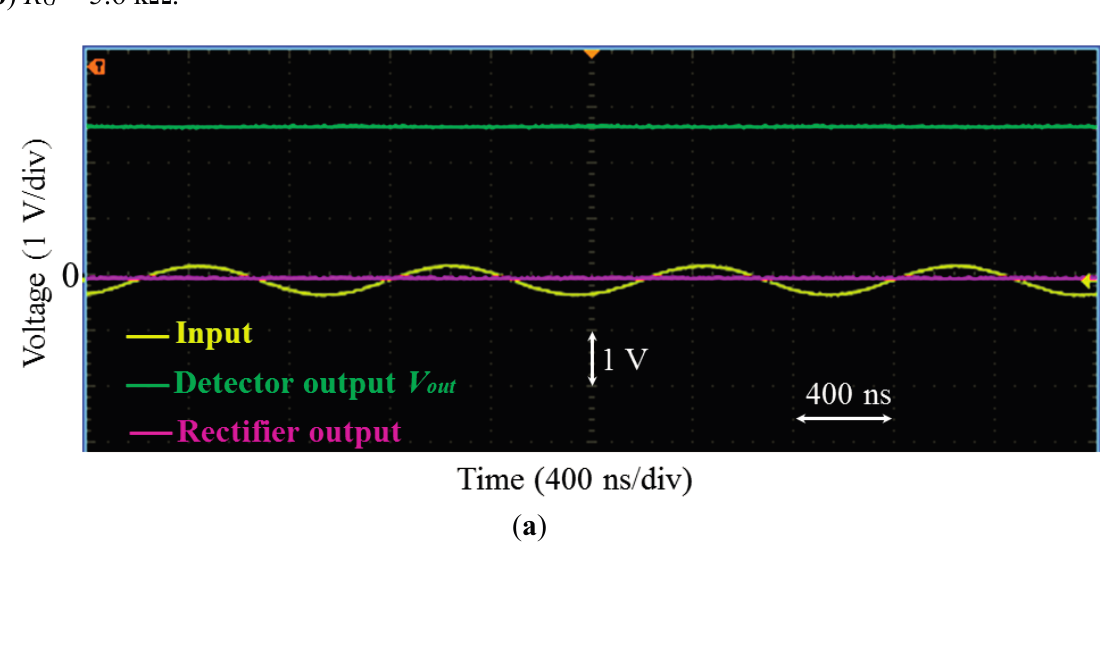
Figure 8. Input signal (yellow color), detector output (green color) and comparator output (magenta color) of a 1 MHz/250 mV signal for two values of feedback resistor. ( a ) R G = 10 k Ω ; ( b ) R G = 5.6 k Ω